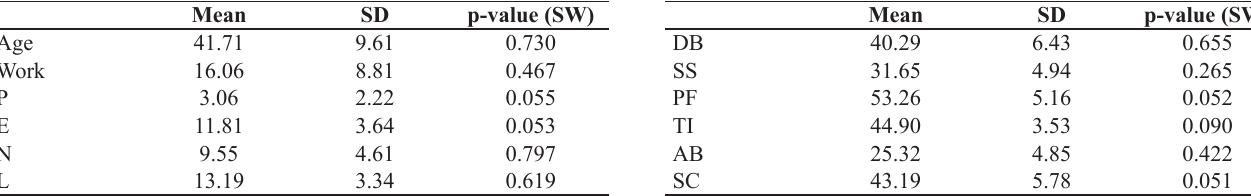
Table 1. Descriptive results of the variables analyzed in the study ( n = 31).